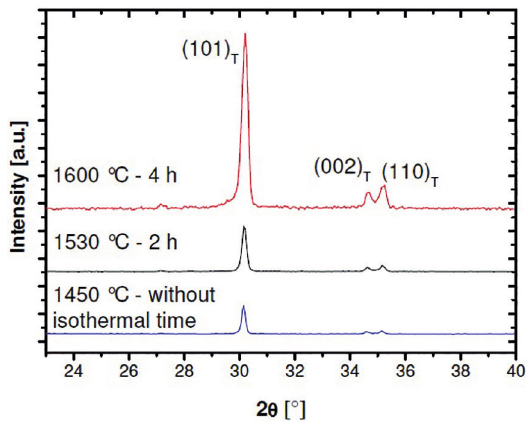
Figure 2: XRD patterns of the sintered samples.